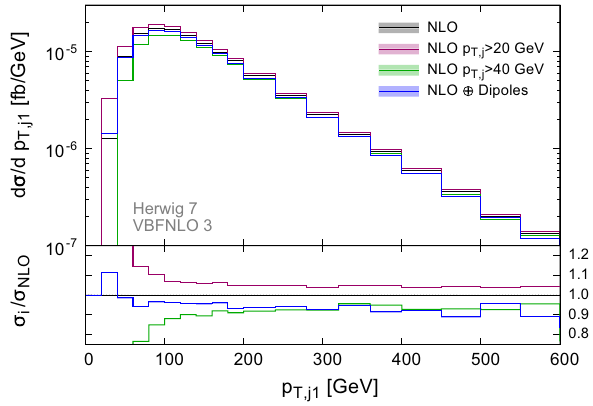
Fig. 2 The transverse-momentum spectrum of the leading jet for a number of different cuts on the fixed-order calculation comparing the central NLO and showered result using a transverse-momentum thresh- old of 30 GeV. Cut migration effects for the central predictions at high transverse momenta are at the level of 10%, while they can have a significant impact in lower- p ⊥ observables